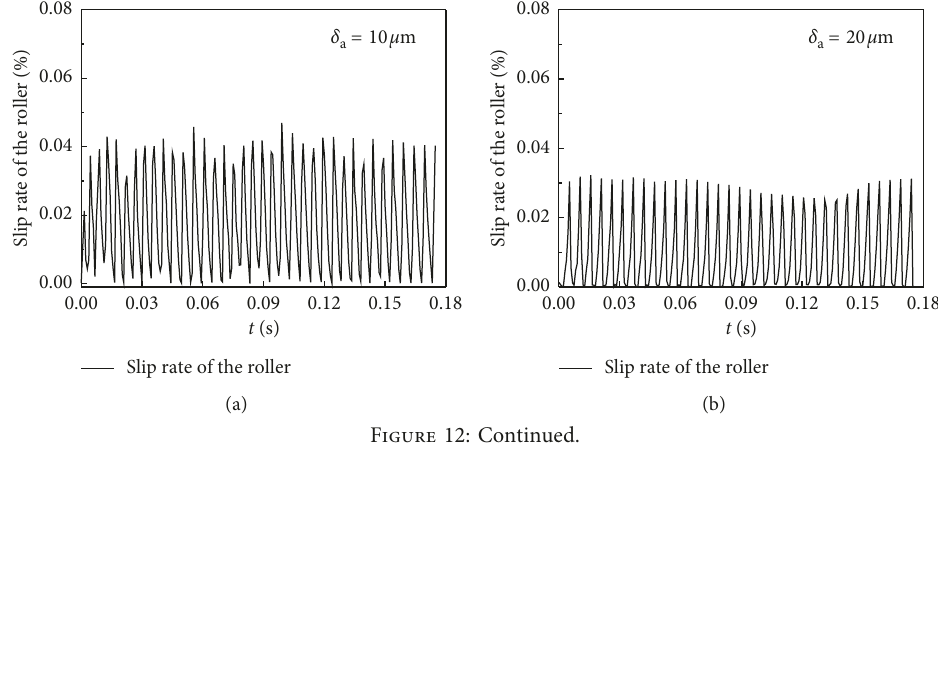
� 0; δ � 10 ∼ 40 μ m; ω r a